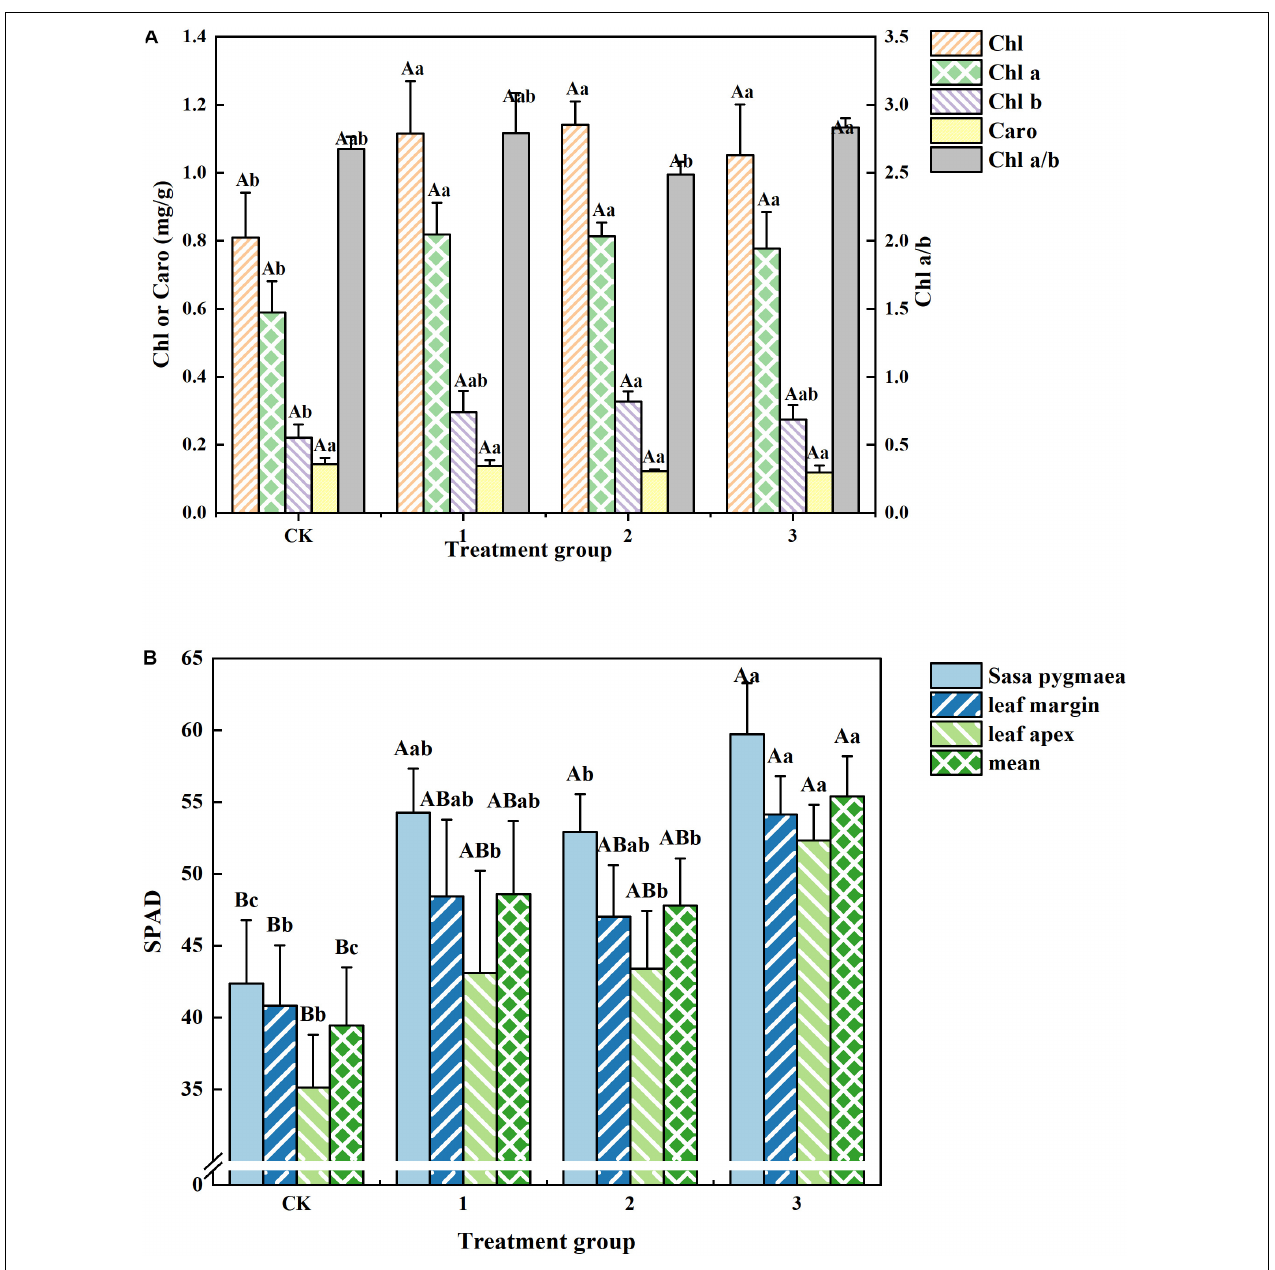
FIGURE 5 | The effect of different treatments on the Photosynthetic pigment content of Horsfieldia hainanmensis . The uppercase letters in the figure indicate P < 0.01, and the lowercase letters indicate P < 0.05, which, respectively, indicate extremely significant and significant differences (A) shows the influence of different light transmittance on Horsfieldia hainanmensis ChlorphyII, Chol a (ChlorphyII A) Chol b (ChlorphyII B), Chol a/b (ChlorphyII A/B), and Caro (carotenoid). (B) Represents the influences of different transmittance on the SPAD value of different position of the blades of Horsfieldia hainanmensis .